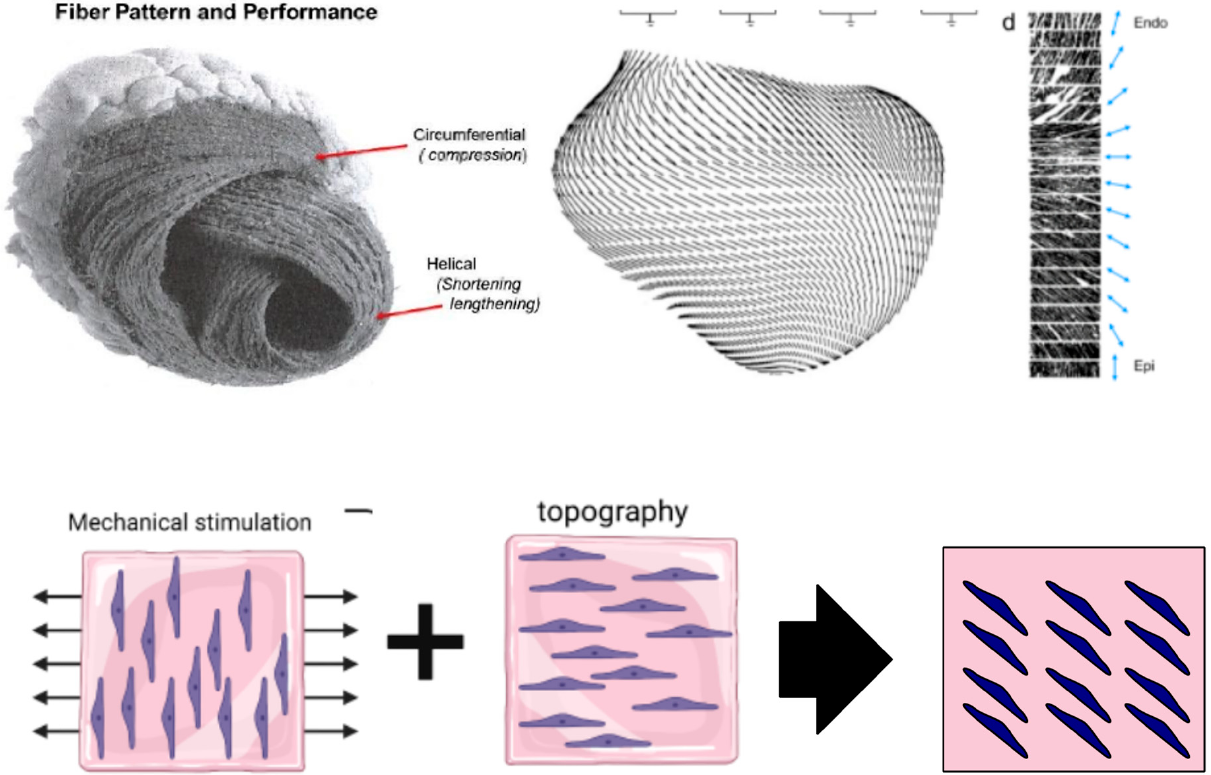
Figure 1. Oblique cell alignment. In the native heart, cellular arrangement is strikingly helicoidal [1,25], with orientation angle changing throughout the heart muscle wall, from endocardium to epicardium. In this work, we address the question of whether combined geometrical and mechanical stimulation can produce cell alignment at oblique angles to the main stress directions, in order to reproduce in vitro oblique cell alignment geometries reminiscent of the organization in the heart.